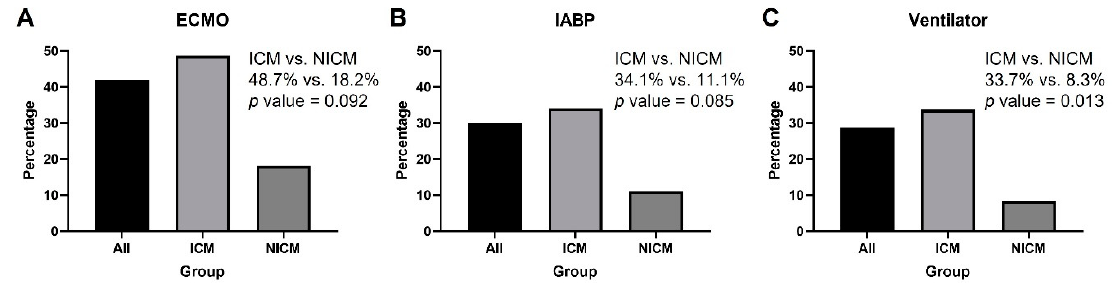
Figure 4. The 30 day all-cause mortality rate in the subgroups on ECMO, IABP, and ventilator: ( A ) the incidence of 30 day all-cause mortality did not differ between the ICM and NICM groups in the patients on ECMO; ( B ) the incidence of 30 day all-cause mortality did not differ between the ICM and NICM groups in the patients on IABP; ( C ) the incidence of 30 day all-cause mortality was higher in patients on a ventilator when comparing the ICM group to the NICM group. ECMO: extra-corporeal membrane oxygenation; IABP: intra-aortic balloon pumping; ICM: ischemic cardiomyopathy; NICM: non-ischemic cardiomyopathy.